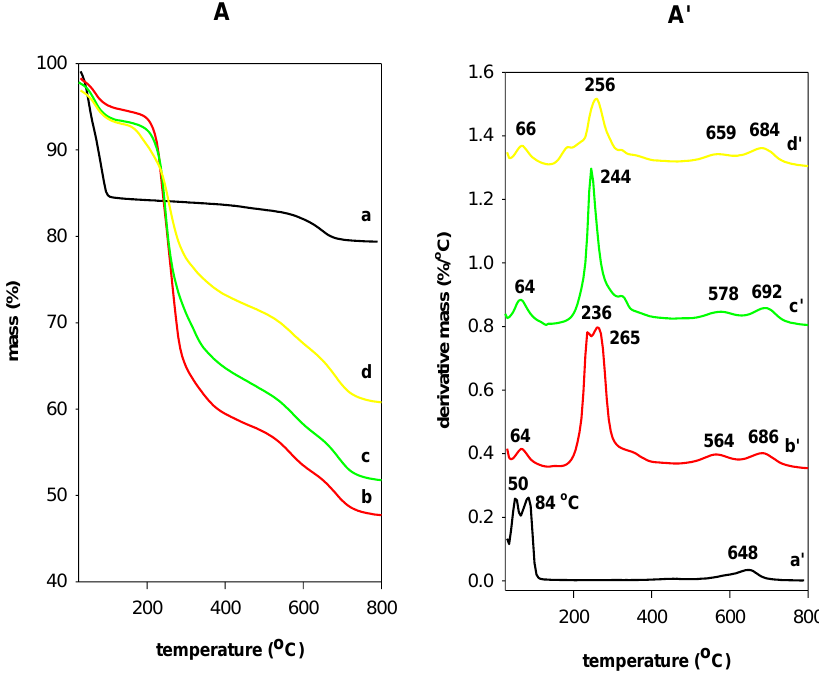
Figure 9. TGA ( A ) / DTG ( A’ ) features of (a, a’) PG modified with different C16TMA solutions at initial loading of 2.40 mmol/g. (b, b’) C16TMABr, (c, c’) C16TMACl and (d, d’) C16TMAOH.